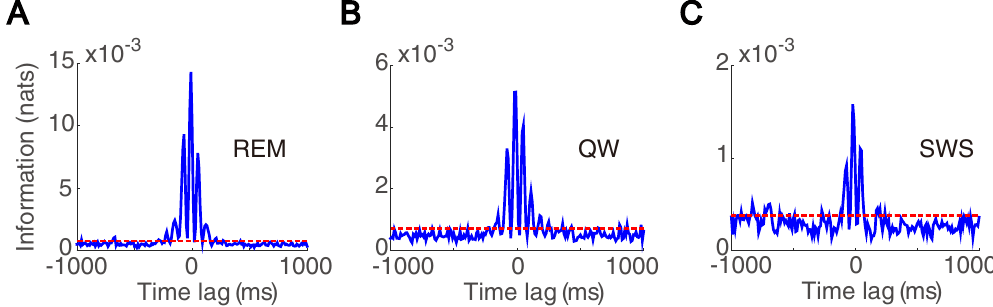
Figure 4. Interaction between a theta-driving neuron and the theta wave over different behavioral states. Time- delayed mutual information (blue) between the theta wave and the firing activity of a theta-driving neuron in the state of ( A ) REM, ( B ) QW, and ( C ) SWS. The red dashed line indicates the significance